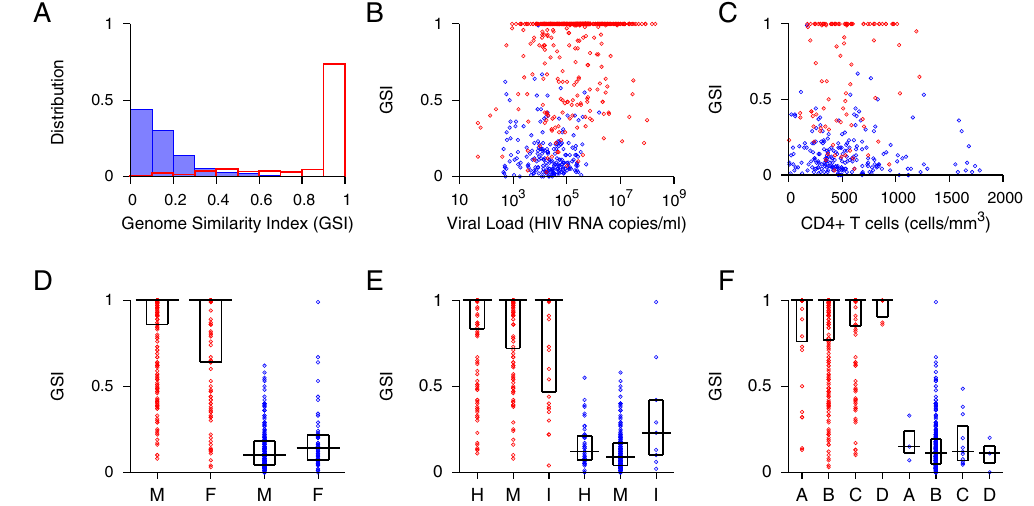
Figure 2. Genome Similarity Index ( GSI ) of incident and chronic infections. ( A ) The GSI distribution of 438 incident specimens is presented in red boxes and that of 305 chronic specimens in blue. The 305 chronic specimens include 274 chronic specimens listed in Table S1, 8 chronic specimens from the longitudinal cohort in Table S3 and 23 chronic specimens from the WIHS cohort in Table 1. The 438 incident specimens consist of 252 single time point incident specimens in Table S2 and 186 incident specimens from the longitudinal cohort in Table S3. All chronic specimens were collected from subjects documented to have been HIV-1 infected for over two years, and all incident specimens were collected within 2 years of HIV-1 infections, according to Fiebig staging and sampling intervals. The two distributions were clearly polarized; the majority of incident subjects had GSIs above 0.9, while all chronic subjects except one had GSIs below 0.67. ( B ) GSI and viral load for incident (red) and chronic (blue) specimens where viral load was available. Viral load did not significantly correlate with 207 chronic specimens’ GSI (Spearman’s correlation ρ = − 0.069 and p = 0.32) but associated with 433 incident GSI (Spearman’s correlation ρ = 0.17 and p < 0.01) although, as indicated by a small correlation coefficient, this association was weak. ( C ) GSI and CD4 + T cell count where available were not statistically correlated in either 104 incident (red) or 209 chronic (blue) specimens (Spearman’s correlation ρ = 0.12 and p = 0.24 and ρ = − 0.11 and p = 0.11, respectively). ( D ) GSI of male (M) and female (F) incident (red) and chronic (blue) specimens. Box plots represent median and first and third quartiles. Incident specimen’s GSI was not sensitive to sex (299 male vs. 142 female, Wilcoxon rank sum test, p = 0.22), but chronic GSI was sensitive (Wilcoxon rank sum test, p = 0.024), presumably due to unbalanced sample size (226 male vs. 55 female) as suggested by overlapping quartiles. In a permutation test, this association was nonsignificant (p = 0.076). ( E ) GSI of incident (red) and chronic (blue) specimens from different risk groups (H: heterosexual, M: men who have sex with men, I: intravenous drug user). Incident GSI was not sensitive to risk behavior (156 heterosexual vs. 143 MSM vs. 34 IDU, Kruskal-Wallis tests, p = 0.094), but chronic GSI was sensitive (Kruskal-Wallis test, p = 0.015), likely due to unbalanced sample size (46 heterosexual vs. 201 MSM vs. 9 IDU). The p-value was 0.009 in a permutation test. ( F ) GSI for incident (red) and chronic (blue) specimens of subtype A, B, C, and D. Neither incident (31 subtype A, 279 subtype B, 134 subtype C, and 6 subtype D) nor chronic (3 subtype A, 280 subtype B, 11 subtype C, and 3 subtype D) GSIs differed significantly among subtypes (Kruskal-Wallis test, p = 0.61 and p = 0.70,